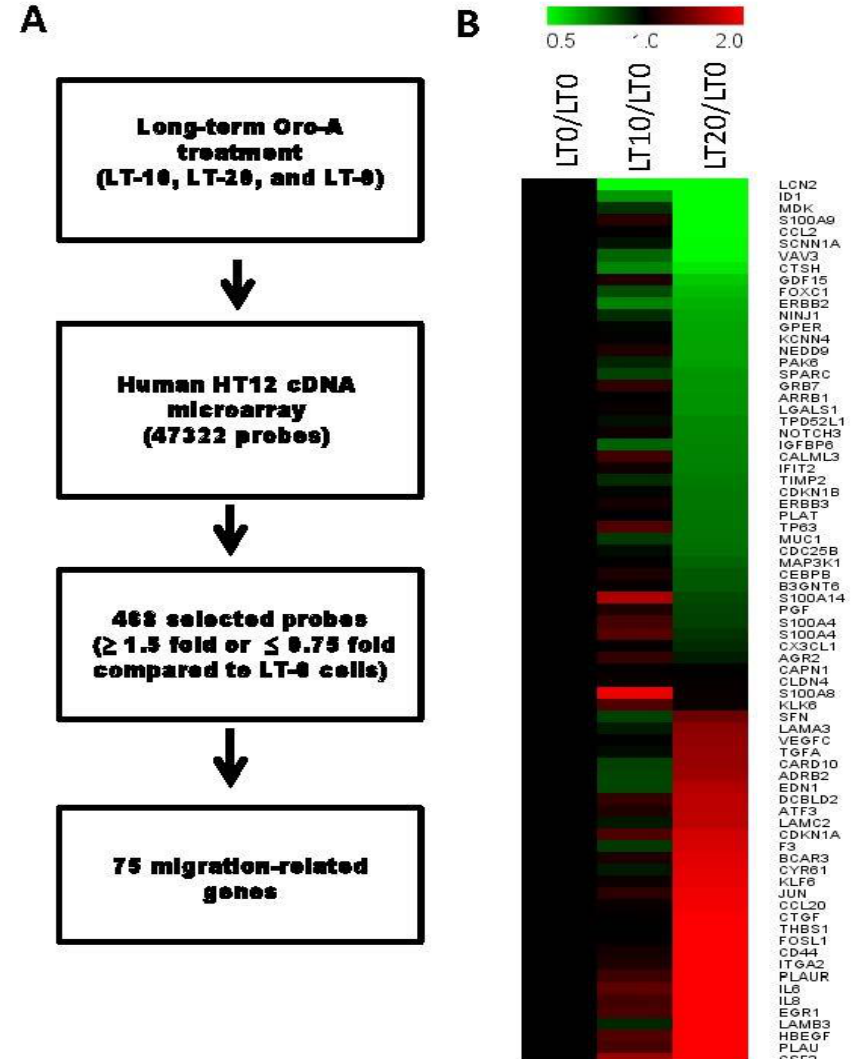
Figure 3. cDNA microarray analysis of gene expression profiles in long-term Oro-A exposed OSCC cells.( A ) Schema for the identification of the migration-related genes affected by long-term exposure to Oro-A. ( B ) Heatmaps showing 75 selected migration-related genes from LT-20 cells. Red represents increased expression; green represents decreased expression.